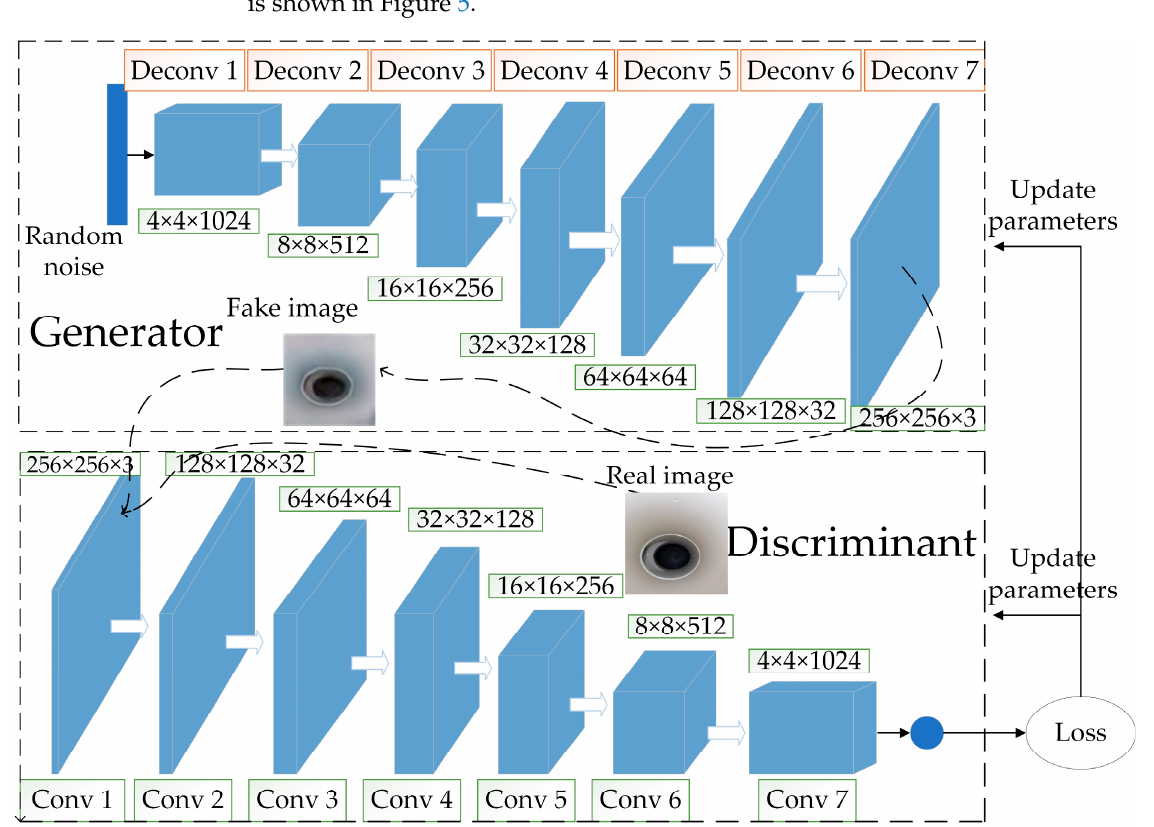
Figure 5. Microleakage generation model for small, buried gas pipelines.